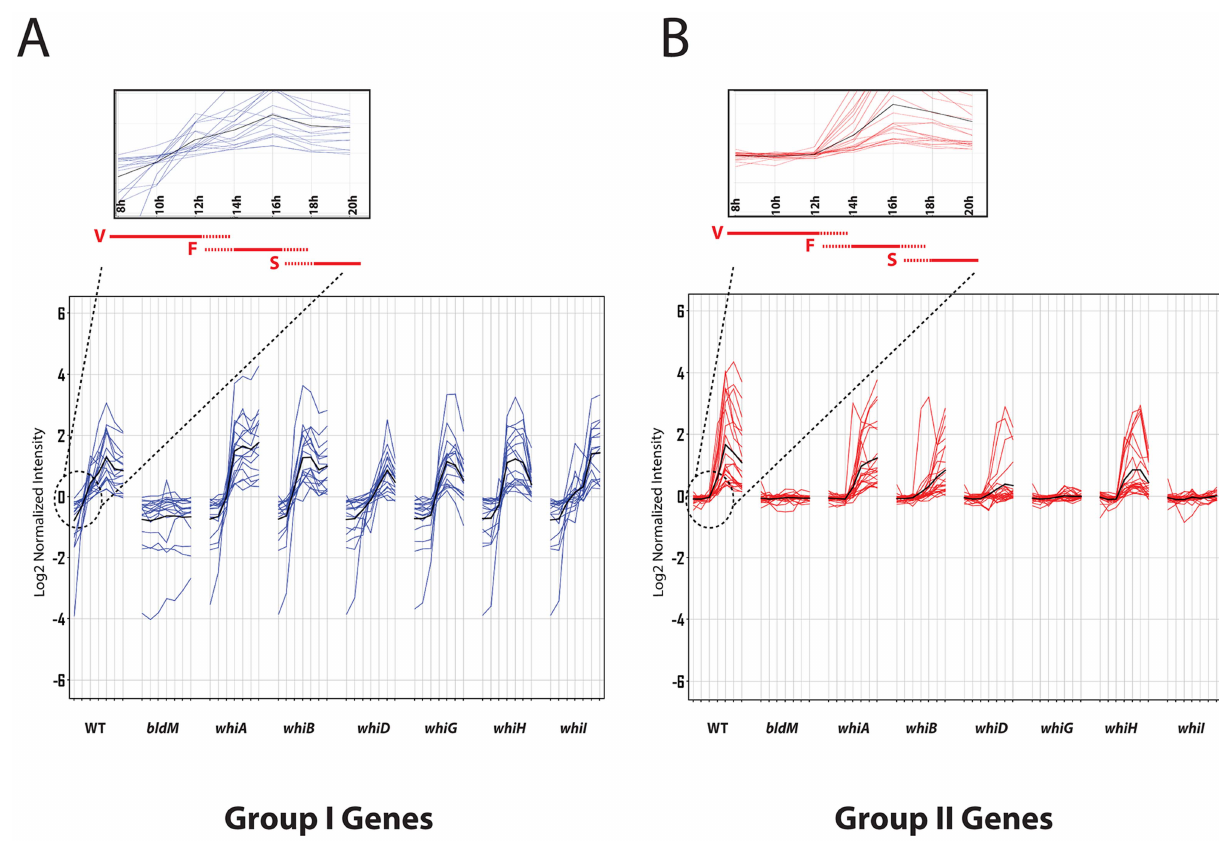
Figure 1. Microarray transcription profiles of (A) Group-I and (B) Group-II genes in wild-type S.venezuelae during submerged sporulation and in congenic D bldM , D whiA , D whiB , D whiD , D whiG , D whiH and D whiI null mutants grown under identical conditions. RNA samples were prepared at 2-hour intervals from 8 to 20 hours, by which time sporulation was nearing completion. For each panel, the x-axis indicates the age of the culture in hours, and the y-axis indicates the per gene normalized transcript abundance (log 2 ). Group-I genes (blue) depend on bldM but are independent of all the whi genes. Group-II genes (red) depend on bldM but also depend whiG and whiI . The average expression profile is indicated by the black line. Group I genes are activated at least two hours earlier than Group-II genes (see insets). Red bars indicate vegetative growth (V), fragmentation of mycelium (F), and spore formation (S).